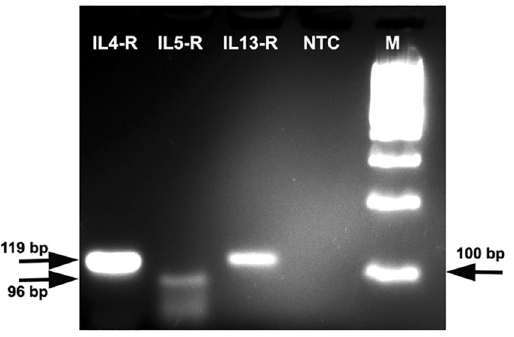
Figure 2. Presence of MUC5AC and cytokine receptors in rat conjunctival goblet cells shown by RT-PCR. M = base pair marker; NTC = non template control; R = receptor; arrows indicate expected base pairs for each receptor.